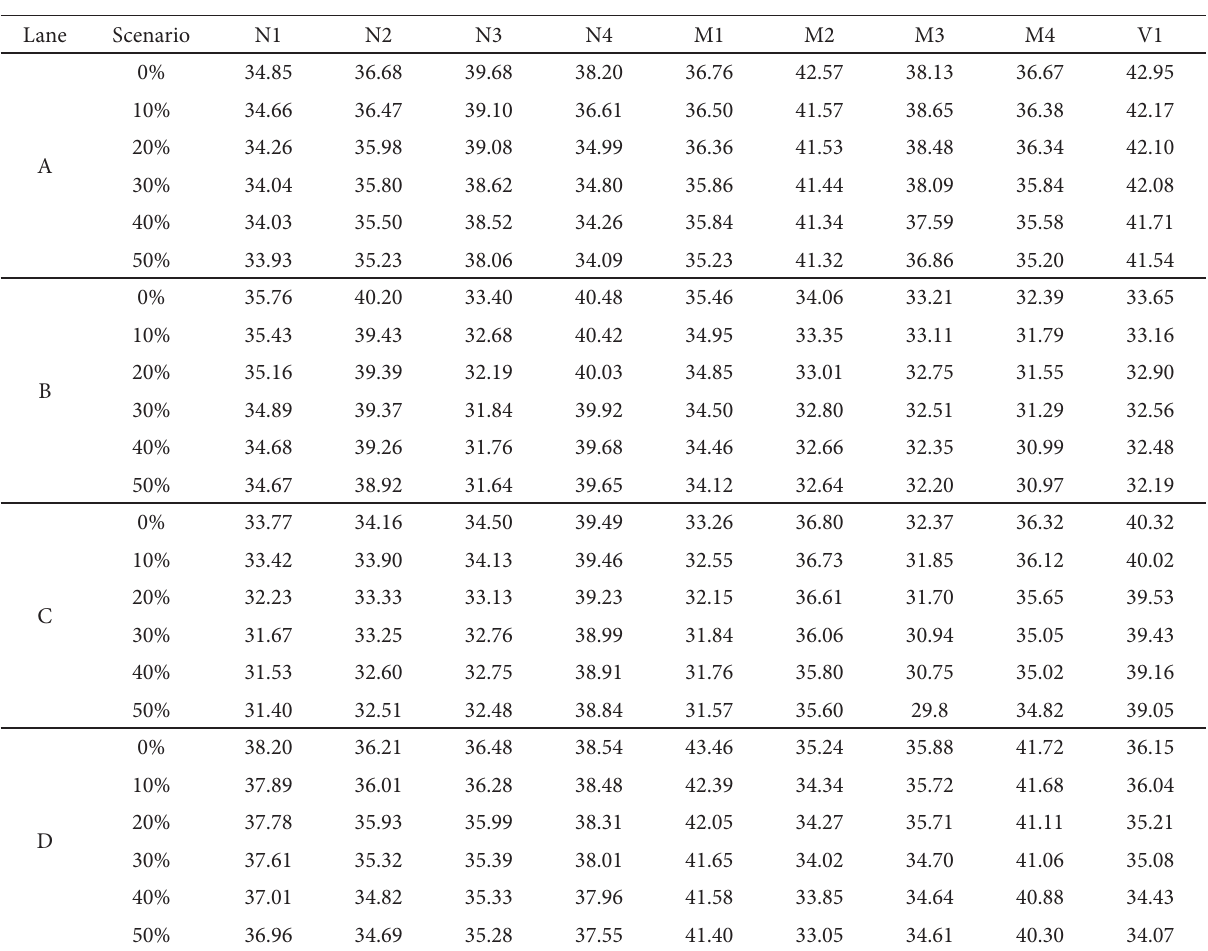
Table 4. Loads in kN/m calculated using influence lines Lane